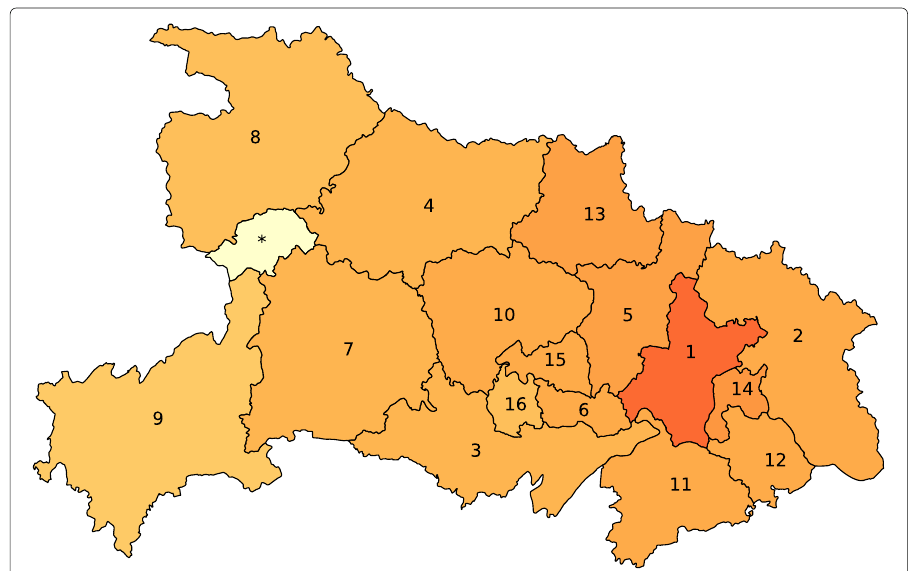
Fig. 1 Map of cities in Hubei . The 17 cities (prefecture-level divisions) of the Chinese province Hubei. The names of the cities are stated in Supplementary Table S2. The greater the fraction of people that have been infected by COVID-19 on February 14, the darker the city. We do not consider the city Shennongjia in this work, which is marked with a star (*) and a light colour